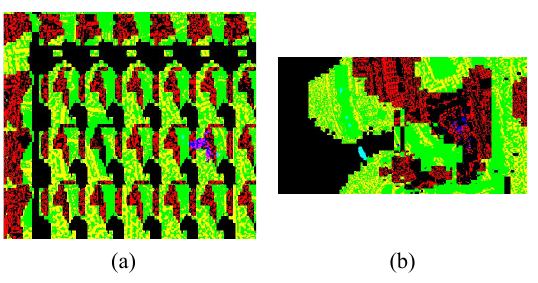
Figure 7. Change detection from the QuickBird image to the WorldView image of (a) “Scene 1” (b) “Scene 2” after 13 years have passed: Red = buildings, Green = vegetation, Blue = water, Yellow = buildings and vegetation, Magenta = buildings and water, Turquoise = vegetation and water, Black: no change or ground (proposed technique). The classified multi-temporal images of Figure 3 have been utilized.